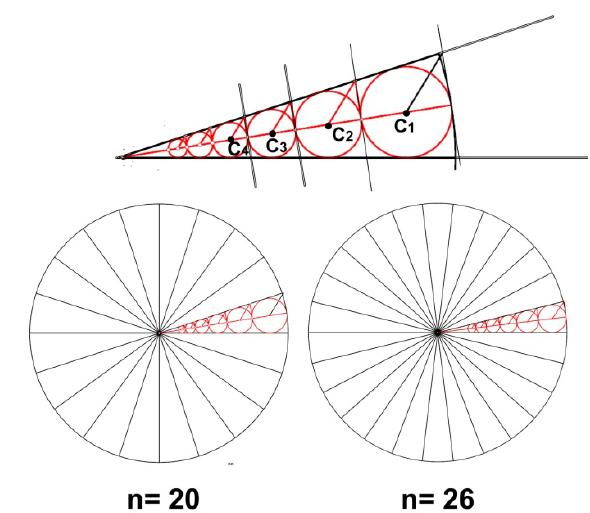
Figure 8. Archimedes theorem on tangent circles: 2D drawing of tangency circles between two (algorithmic model) converging